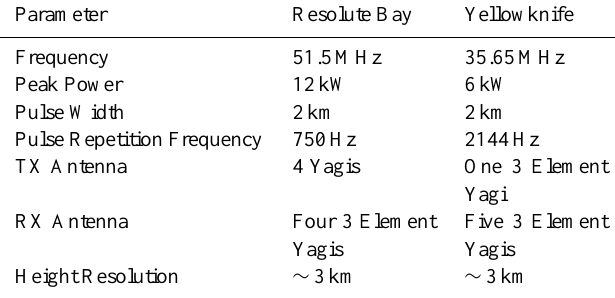
Table 1. Basic parameters of the Resolute Bay VHF radar and Yel- lowknife SKiYMET